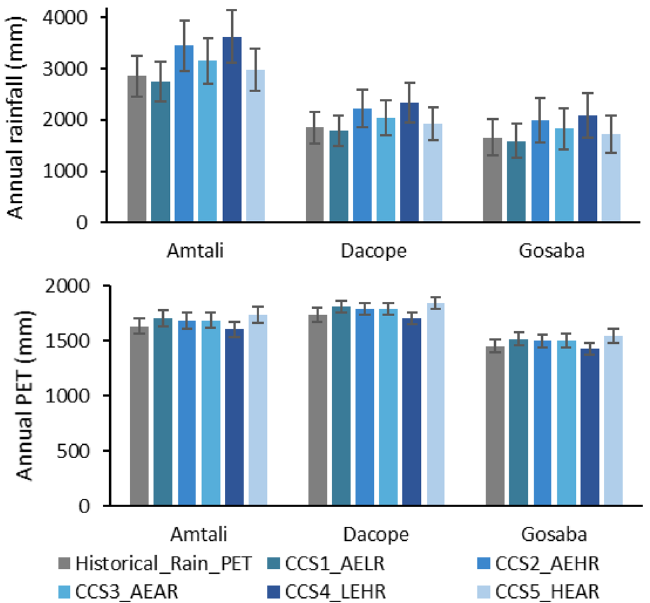
Figure 4. Comparison of the annual average rainfall (top) and potential evapotranspiration (PET, bottom) for the historical period and for the climate change scenarios (CCS1_AELR: average PET and low rainfall, CCS2_ AEHR: average PET and high rainfall, CCS3_AEAR: average PET and average rainfall, CCS4_LEHR: low PET and high rainfall, CCS5_HEAR: high PET and average